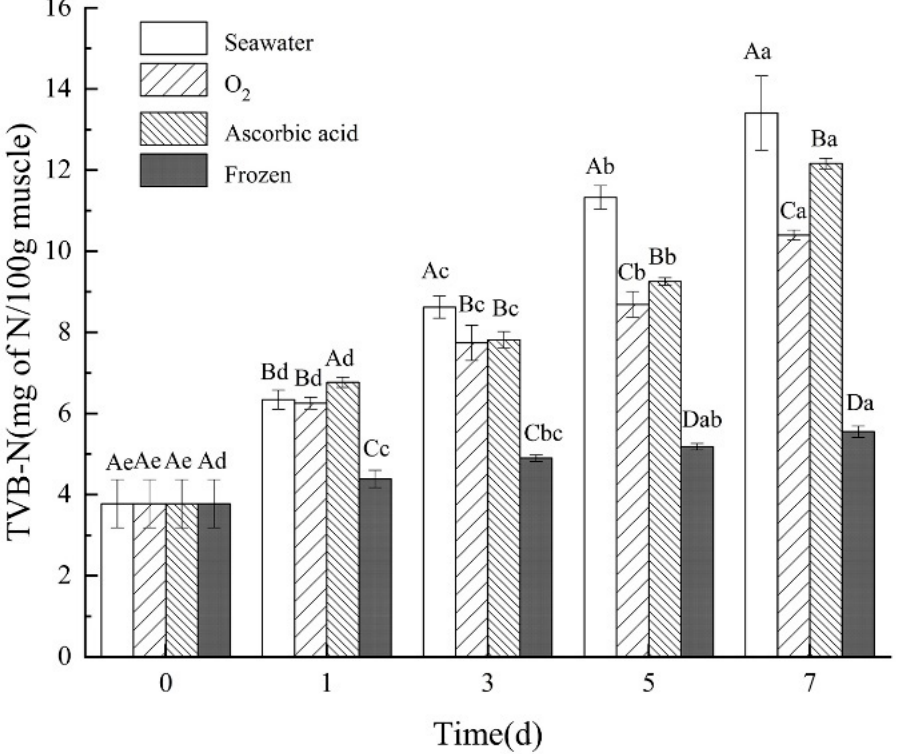
Figure 6. Changes in TVB-N in different treatment groups during storage. Dates are presented as mean ± SD ( n = 6). Different capital letters indicate significant differences in the average between groups. Different lowercase letters indicate significant differences in the average value within each group ( p < 0.05).